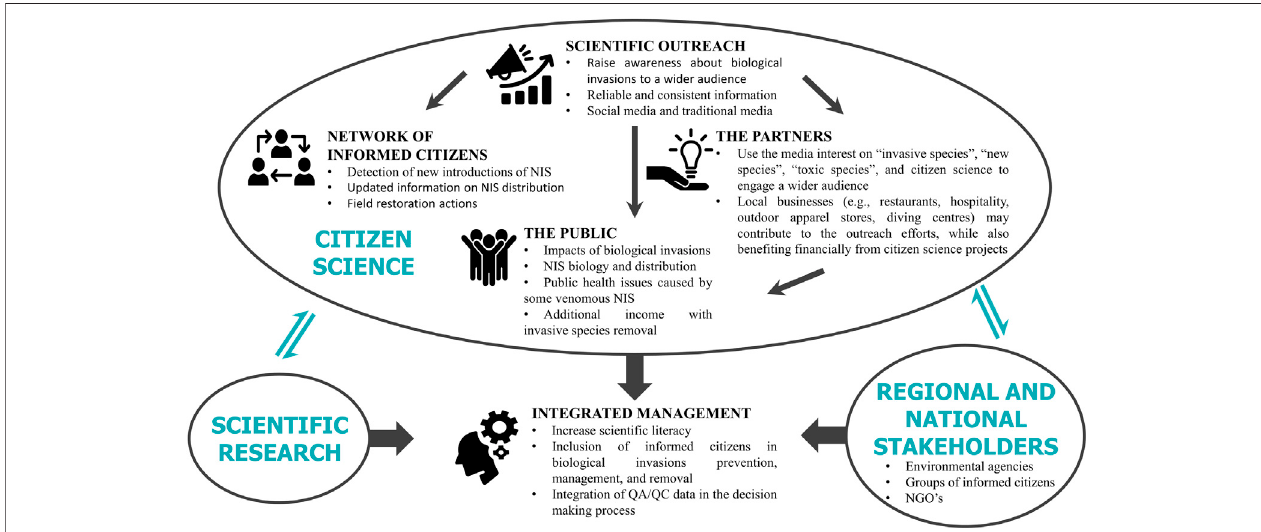
FIGURE 6 | Diagram proposing how outreach activities promoted by scientists can be boosted with the aid of the media and local businesses to reach a higher audience and inform several segments of the public with credible information about biological invasions. The media and the public, but also a network of informed citizens, are essential for building a solid citizen science project. The contributions from citizen science and national and regional stakeholders complement those from scienti fi c research to attain a more solid integrated management of biological invasions. Icons retrieved from the Noun Project (www.thenounproject.com).